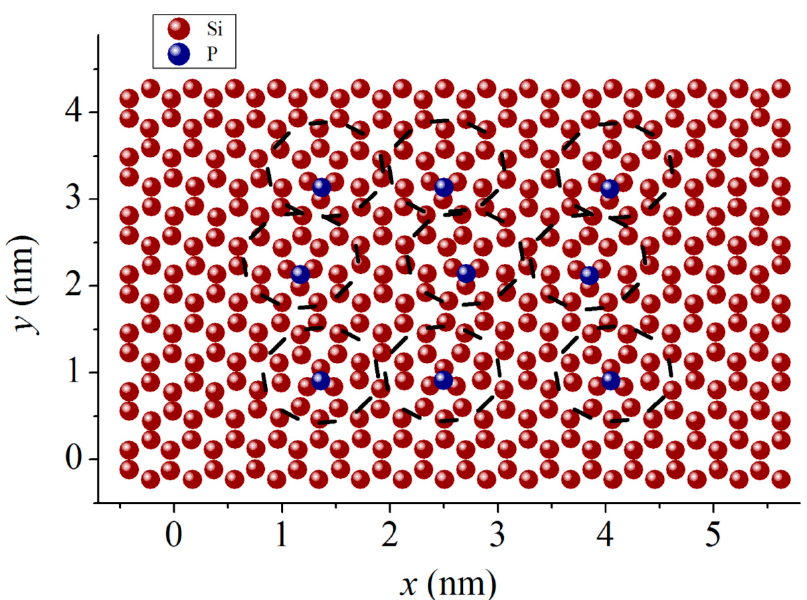
Figure 13. Xy projection of the top silicene sheet after filling the doped silicene channel with lithium for 100 ps; dashed circles represent the transformation areas of the P-doped